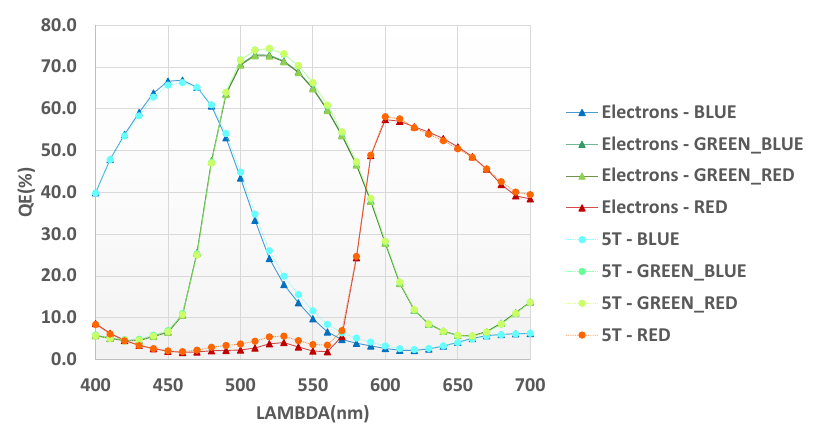
Figure 12. QE benchmark versus non-HDR pixel.